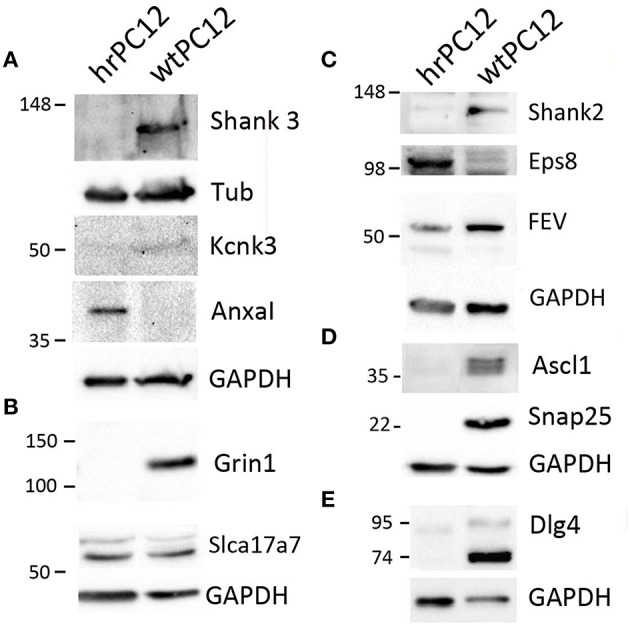
Proteins encoded by genes differentially expressed in hrPC12 and wtPC12 cells. Representative results of western blots of 11 proteins analyzed 2–4 times. Panel (A) shows the results of the repressed post-synaptic protein Shank3 and K+ channel Kcnk, with the up-regulated annexin1 (Anxal); controls with tubulin (Tub), and GAPDH. Panel (B) shows the results of the repressed Grin1, a subunit of the NMDA receptor, and the unchanged Slca17a7 Na+ transporter, with GAPDH control; Panels (C–E) show the repressed post-synaptic protein Shank2, transcription factor Ascl1, SNARE protein SNAP25, and MAGUK Dlg4, together with the moderately repressed FEV and the up-regulated synaptic protein Eps8. Controls with GAPDH.